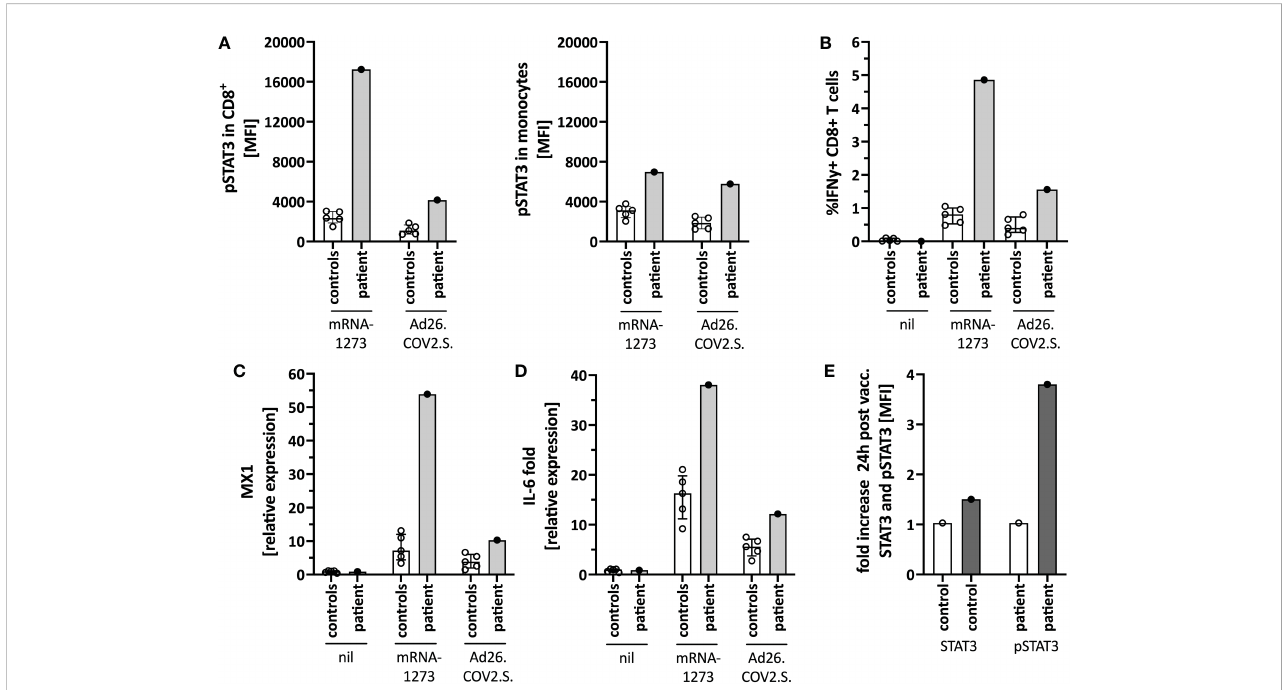
FIGURE 4 Immune activation by mRNA-1273 and Ad26.COV2.S vaccines. (A) STAT3 phosphorylation in CD8+T cells (left) and monocytes (right) following in vitro stimulation of peripheral blood immune cells with the mRNA-1273 vaccine or Ad26.COV2.S vector vaccine (pre-vaccine dose 2; i.e. different timepoint than in Figure 1D). (B) Vector vaccine stimulation induced lower T cell activation in vitro than the mRNA vaccine. (C) MX1 (=Interferon stimulated gene (ISG)) and (D) IL-6 induction upon in vitro stimulation with mRNA-1273 or Ad26.COV2.S is shown by qPCR. (E) Mild in vivo pSTAT3 activation 24 hours following vaccination with Ad26.COV2.S. Data is expressed as fold change of STAT3 or pSTAT3 activation 24h-post-vaccination normalized to an unvaccinated control. Nil= unstimulated condition= media only. ctrl= healthy controls; px=